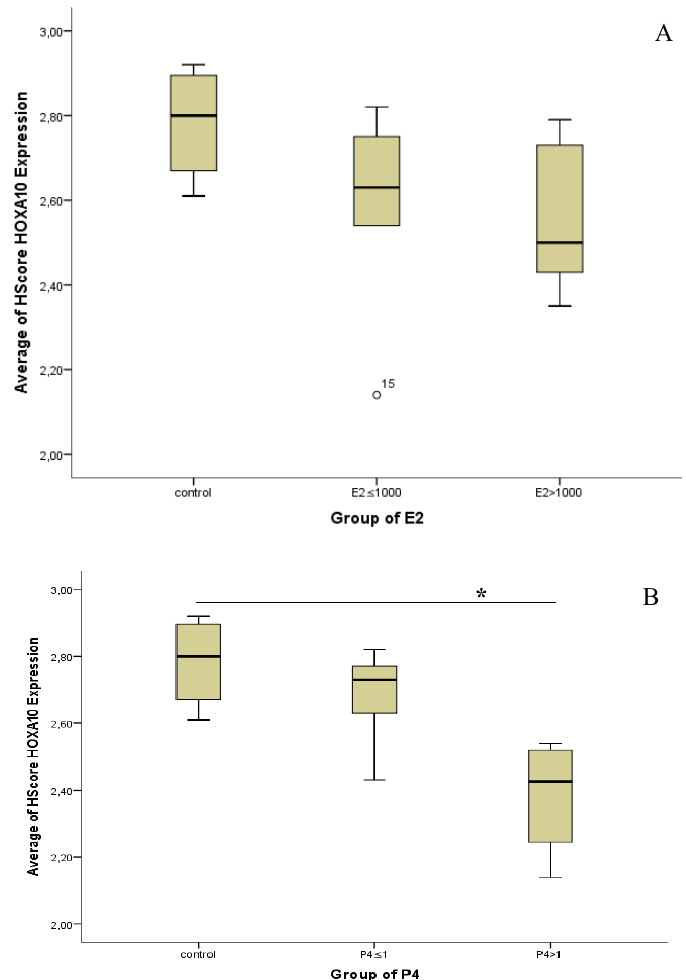
Figure 3. HOXA10 and steroid level on the day of hCG administration. The Kruskal–Wallis test was used, and no statistically significant di ff erences were found in the average of the Hscore for HOXA10 within E2 groups ( p -value, 0.190) ( A ). Statistically significant di ff erences were found in the average of the Hscore for HOXA10 within P4 groups ( p -value, 0.022), where the significance was found in the P4 > 1 group with the natural group ( p -value, 0.029) ( B